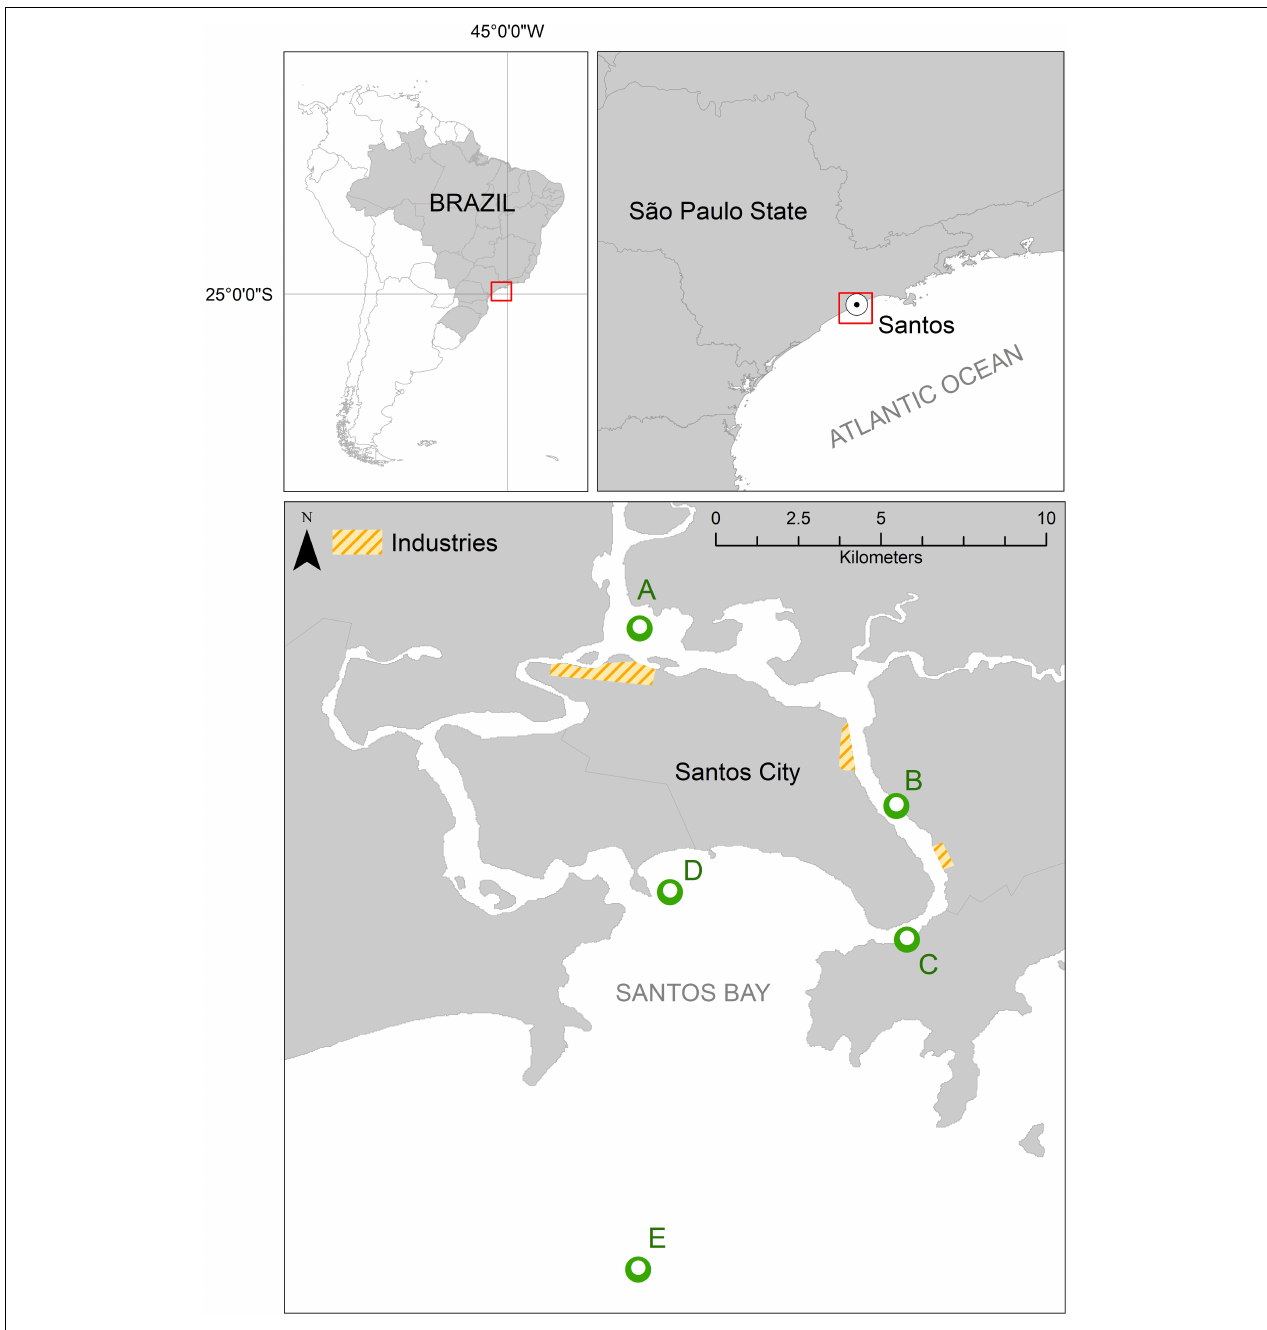
FIGURE 1 | Details of the Santos Estuarine System (SES), within the Central Region of São Paulo State, in south eastern Brazil. Letters give modeled release points: A (upper estuary), B (mid estuary), C (estuary mouth), D (inshore beach) and E (offshore) for microplastic pellets. Hashing indicates areas with a high concentration of industries that produce and/or consume microplastic